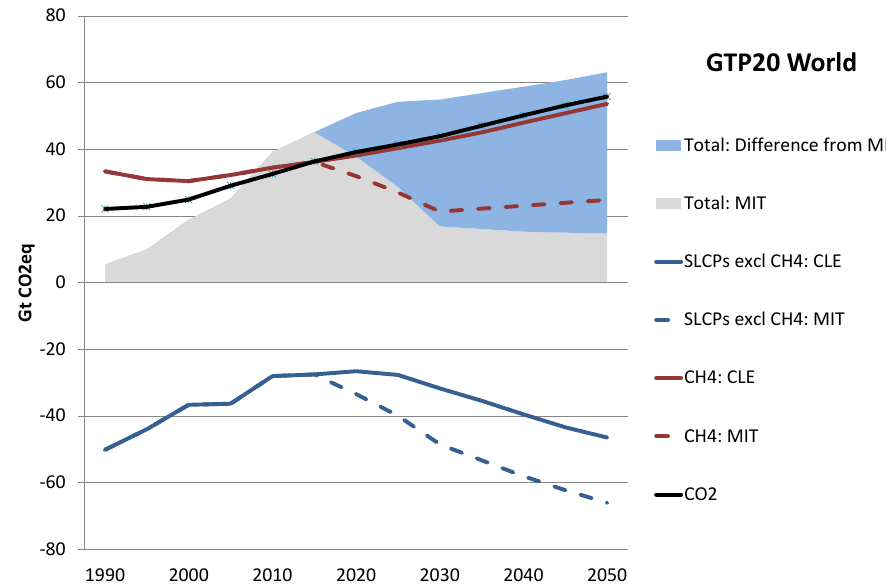
Figure 9. CO 2 -equivalent emissions (Gt) determined with the GTP 20 metric, as a function of time, for global emissions of the current legislation (CLE) and SLCP mitigation (MIT) scenarios. Lines show the values for individual forcing components (black CO 2 , red CH 4 , blue other SLCPs), while the shaded areas show the total CO 2 -equivalent emissions from all SLCPs and CO 2 . The blue shading indicates the mitigation potential of MIT, compared to